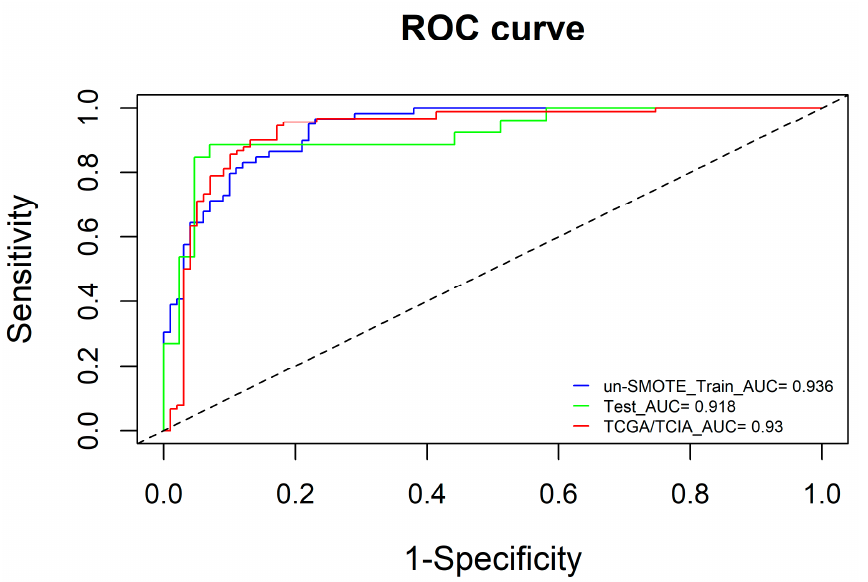
Figure 10. ROC curves of the combined model in the un-SMOTE training cohort, test cohort and independent TCGA/TCIA validation